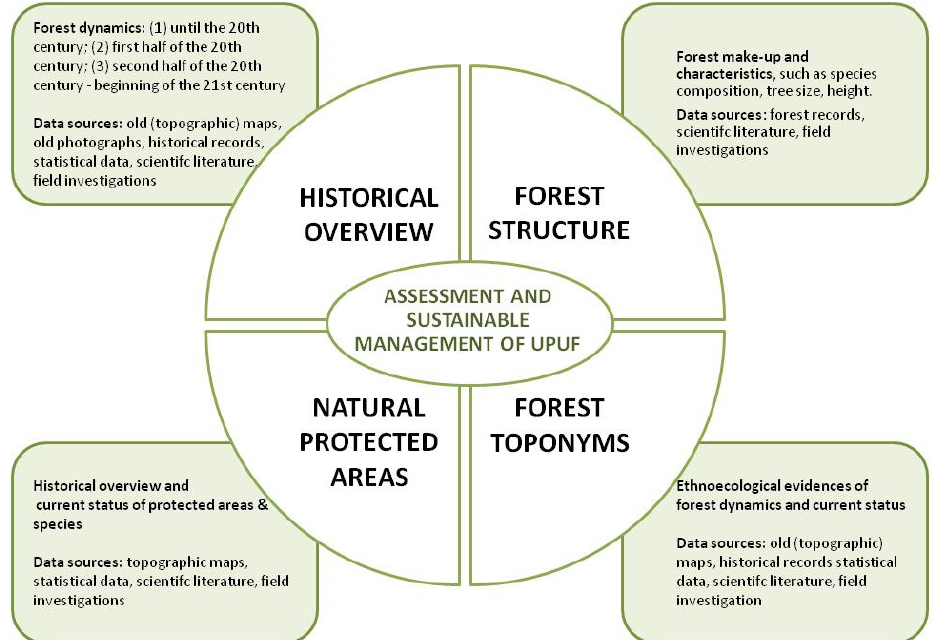
Figure 1. Data integration and methodological outline.